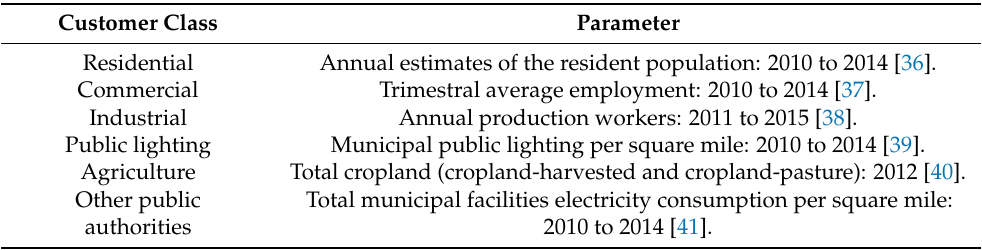
Table 4. Parameters considered to the calculation of electricity consumption by